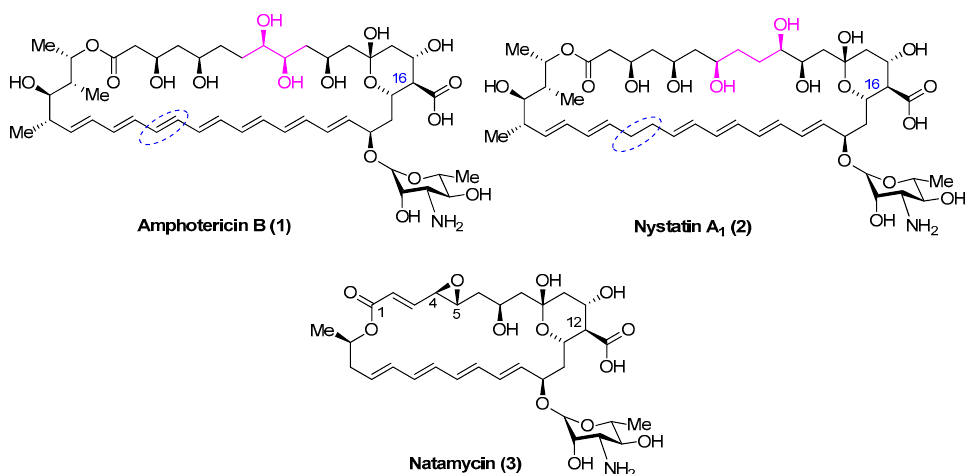
Figure 1. Structure of polyene antibiotics amphotericin B, nystatin A 1 and natamycin .